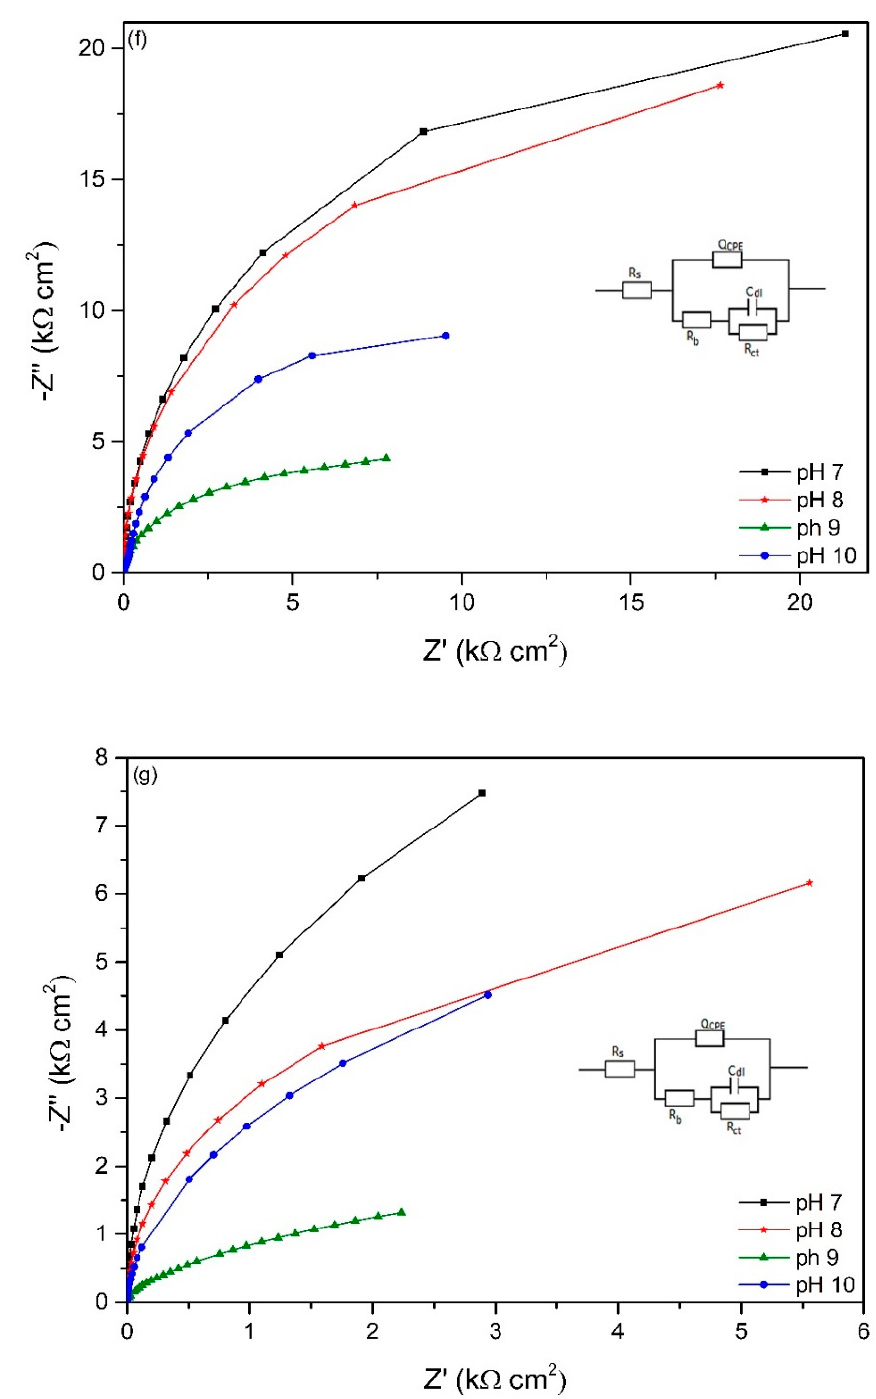
Figure 6. Nyquist plots of working electrodes at different starting pH after ( a ) 2 h, ( b ) 2 days, ( c ) 4 days, ( d ) 14 days, ( e ) 18 days, ( f ) 22 days and ( g ) 28 days exposure based on the EEC model in each